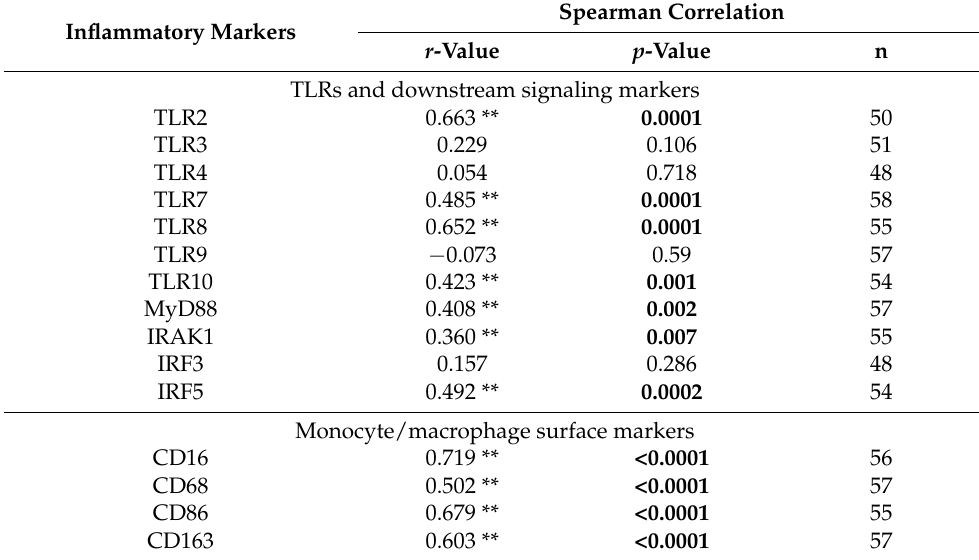
Table 3. Correlation of AT dectin-1 transcripts with that of the Toll-like Receptors (TLRs), downstream singling molecules and AT resident monocyte/macrophage